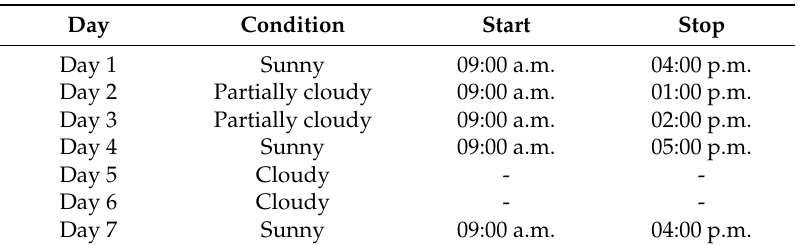
Table 4. Reference working profile.